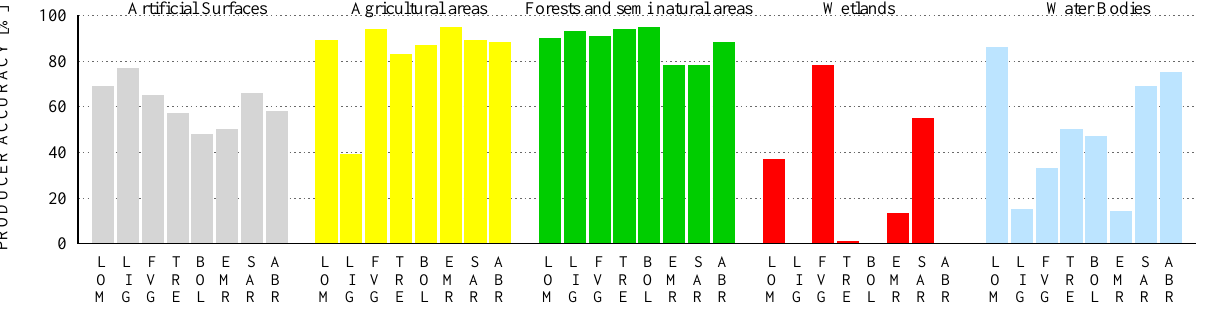
Figure 10. Comparison between GlobeLand30 2000 and Italian regional datasets (I reclassification, no buffer case): user accuracies for each class and dataset.